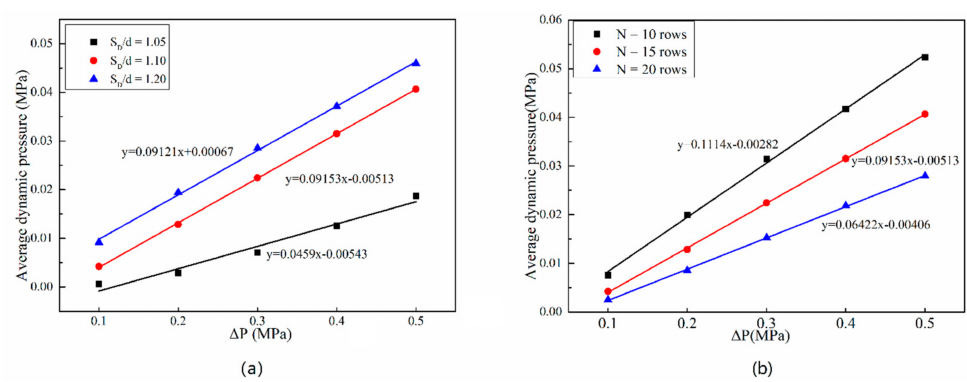
Figure 7. The average dynamics pressure with different S D /d ( a ) and different rows ( b ). The number of axis rows is 15 rows in ( a ), and the magnitude of S D /d = 1.10 in ( b